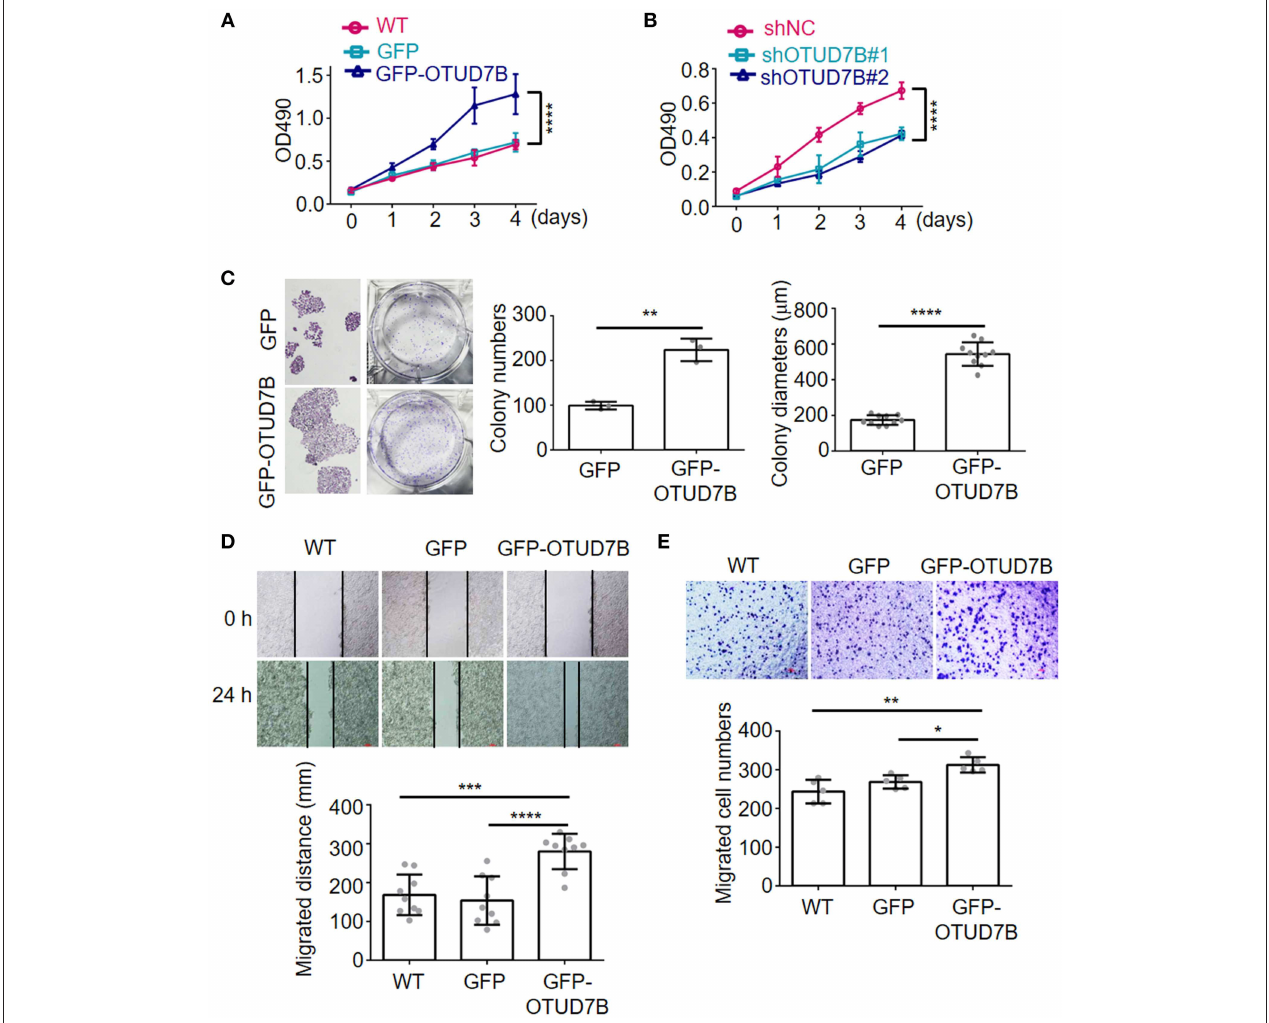
FIGURE 2 | OTUD7B promotes proliferation, migration and colony formation in lung cancer cells. (A,B) NCI-H358 lung cancer cells were transduced with GFP or GFP-OTUD7B (A) or transduced with a non-targeting control shRNA (shNC) or two different OTUD7B-specific shRNAs (B). Cells proliferation was tested using MTT assay and the absorbance was measured at 490nm. (C) NCI-H358 cells were transduced with GFP or GFP-OTUD7B. Cell proliferation were determined by colony formation analysis. (D,E) Wound healing assay (D) and transwell invasion assay using Boyden chamber (E) in NCI-H358 cells were performed and photographed under a light microscope (magnification, × 100). Representative images are shown (upper panels). Data are shown as mean ± s.d. * P < 0.05, ** P < 0.01, *** P < 0.001, **** P < 0.0001.